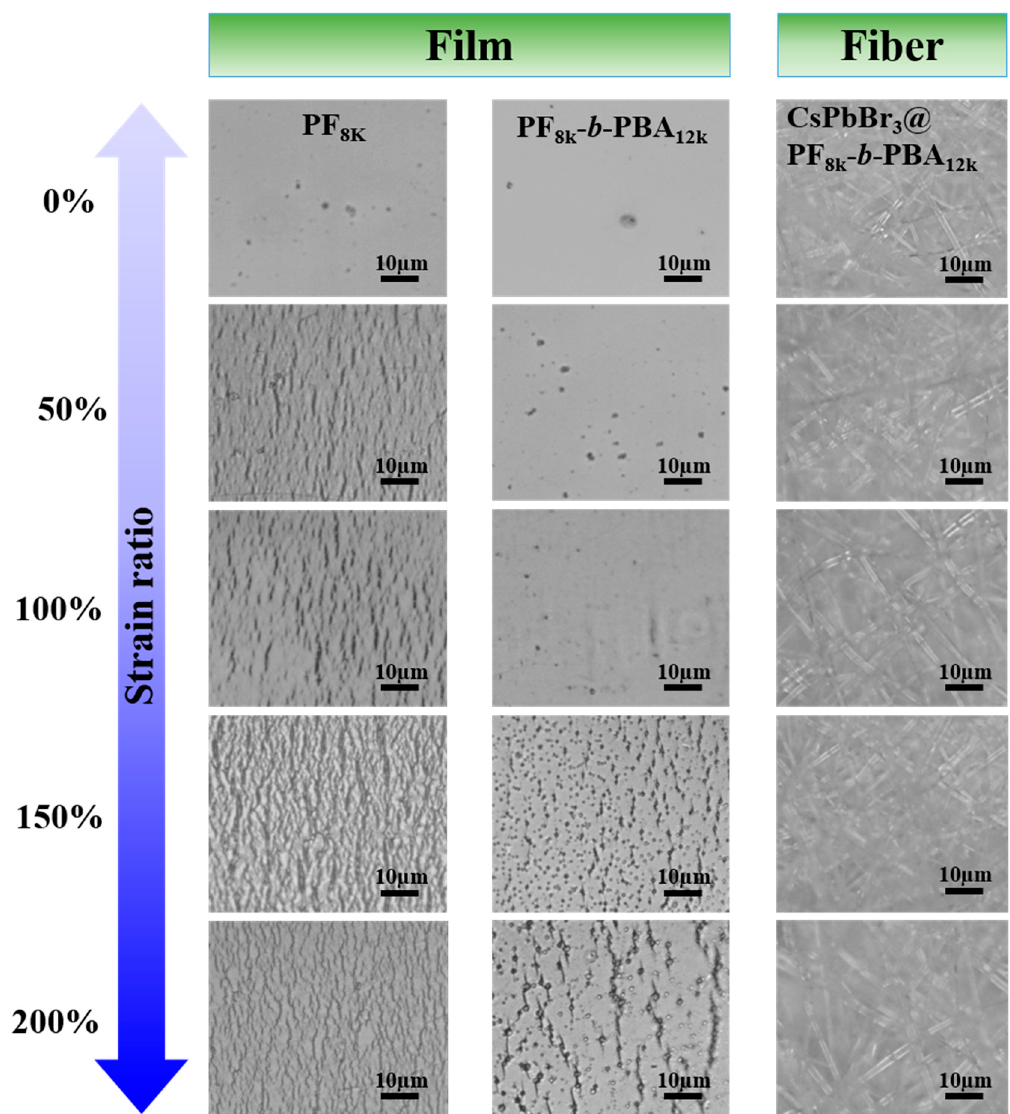
Figure 3. The crack-onset test for the PF 8k and PF 8k - b -PBA 12k films and CsPbBr 3 @PF 8k - b -PBA 12k composite fibers (1 g/400 μ L).